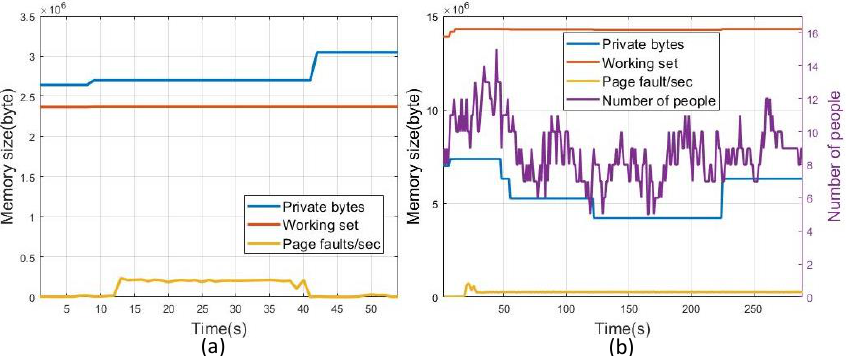
Figure 13. ( a ) Memory usage of lane detection algorithm, ( b ) Memory usage of the people count